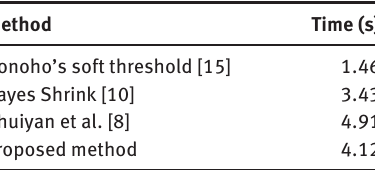
Table 7: Comparison of De-noising Algorithms in Terms of Computational